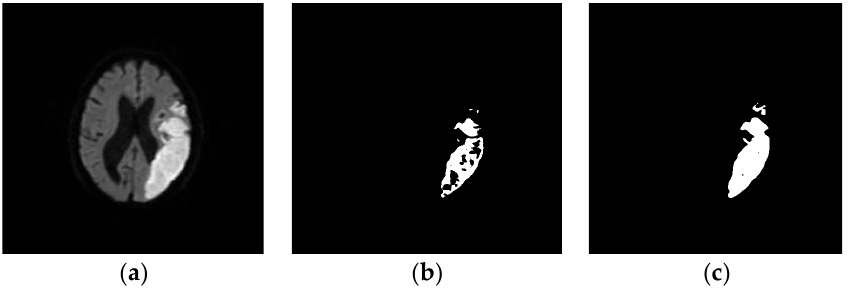
Figure 6. Large ischemic stroke lesion is seen on the original DWI ( a ), with lesion detected using PSO ( b ) and fractional-order DPSO ( c ) [99].